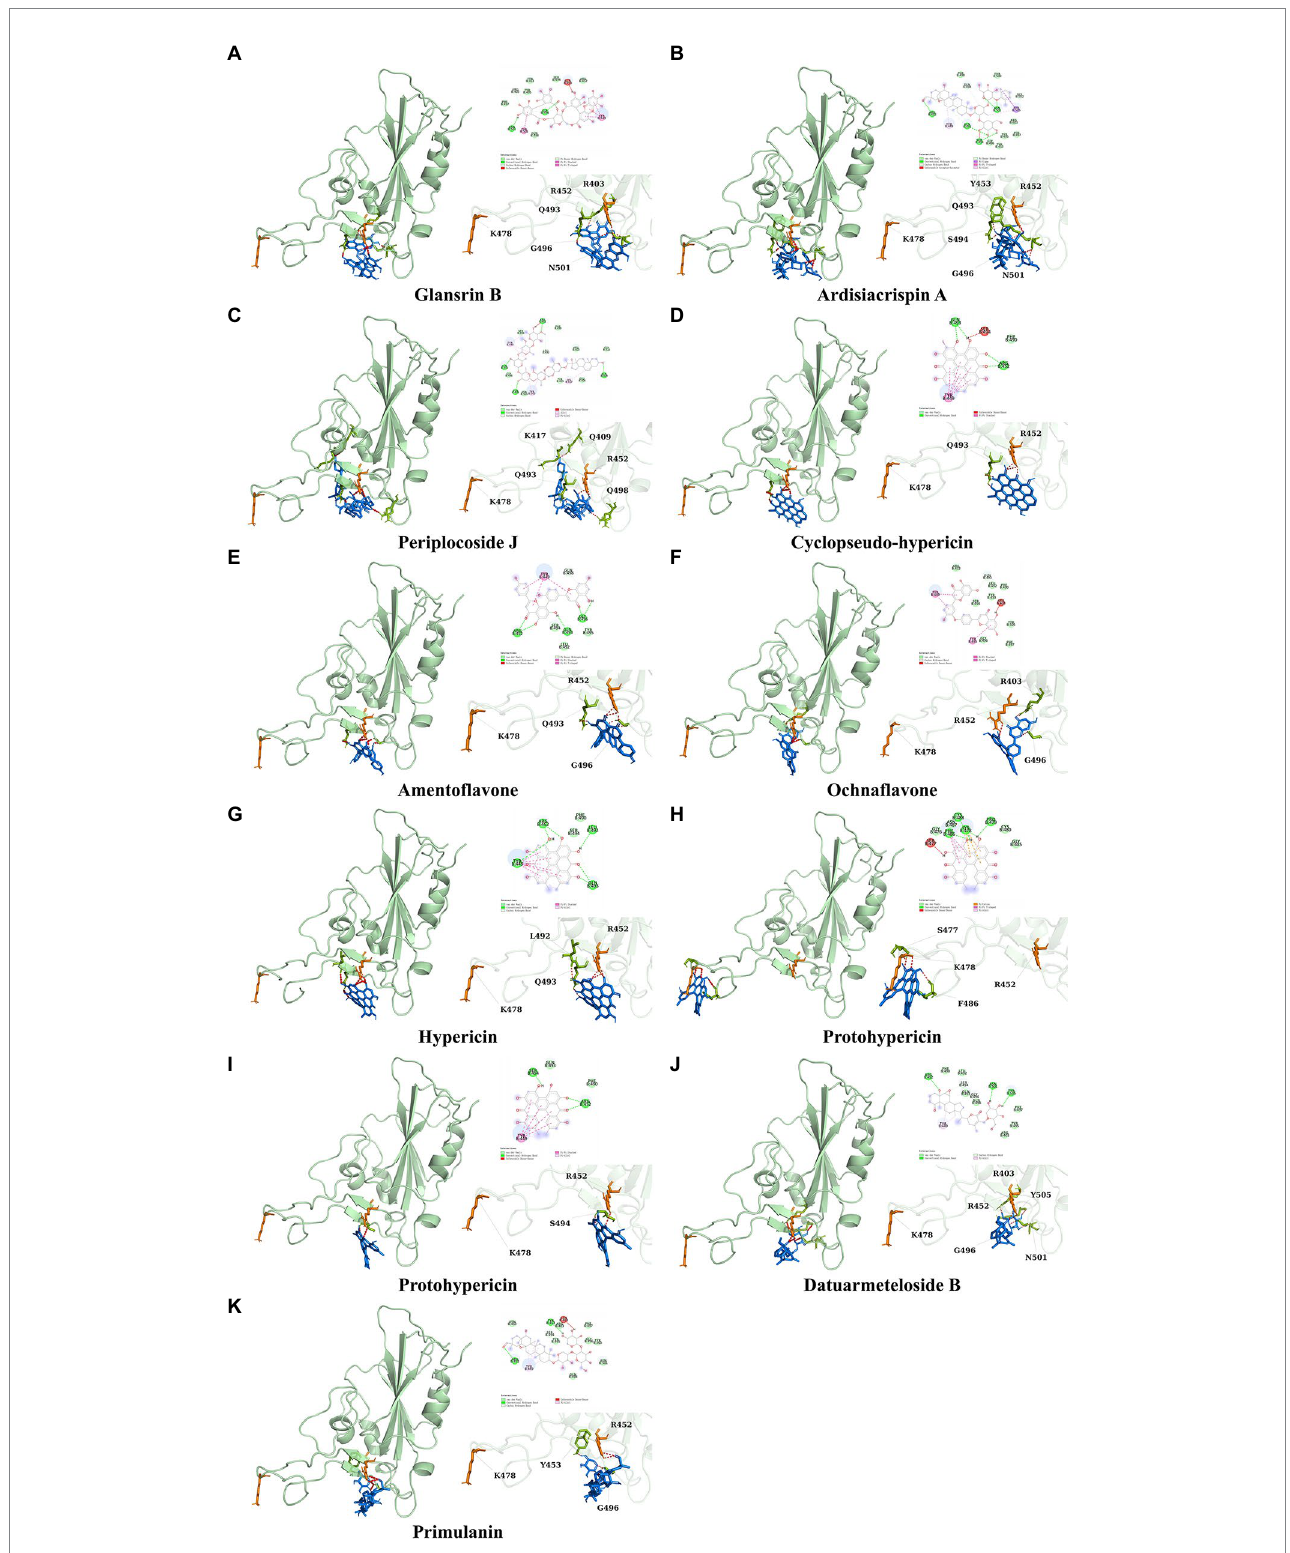
FIGURE 4 The top 10 conformations of the small molecule compounds bind to the Delta strain mutation base. (A) Glansrin B. (B) Ardisiacrispin A. (C) Periplocoside J. (D) Cyclopseudo-hypericin. (E) Amentoflavone. (F) Ochnaflavone. (G) Hypericin. (H, I) Protohypericin. (J) Datuarmeteloside B. (K)